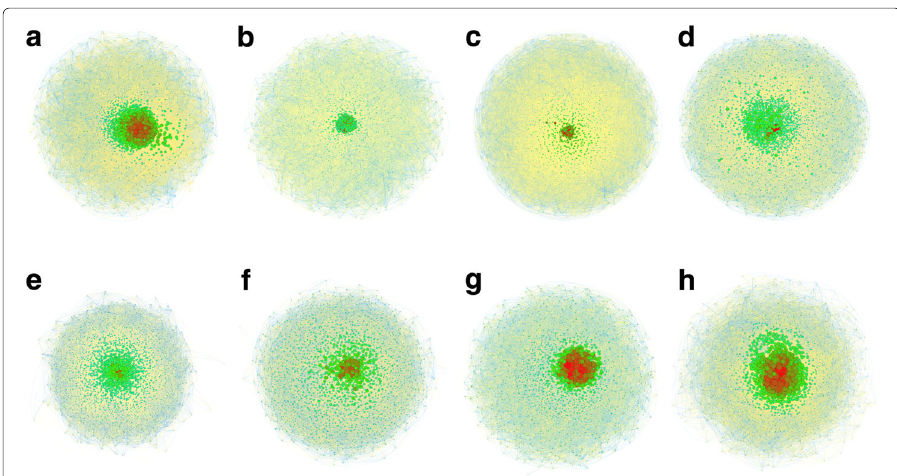
Fig. 2 Dynamic evolution of companies in London Stock Exchange from 1977 to 2017, depicting small-world effect in networks at each step. Node color and size: large red, high degree of centrality; small blue, low degree. Edge color: yellow, positive edge; light-blue, negative edge. Thickness of edges is proportional to weight. a 1977-1978; b 1983-1984; c 1988-1989; d 1993-1994; e 1997-1998; f 2003-2004; g 2009-2010; and